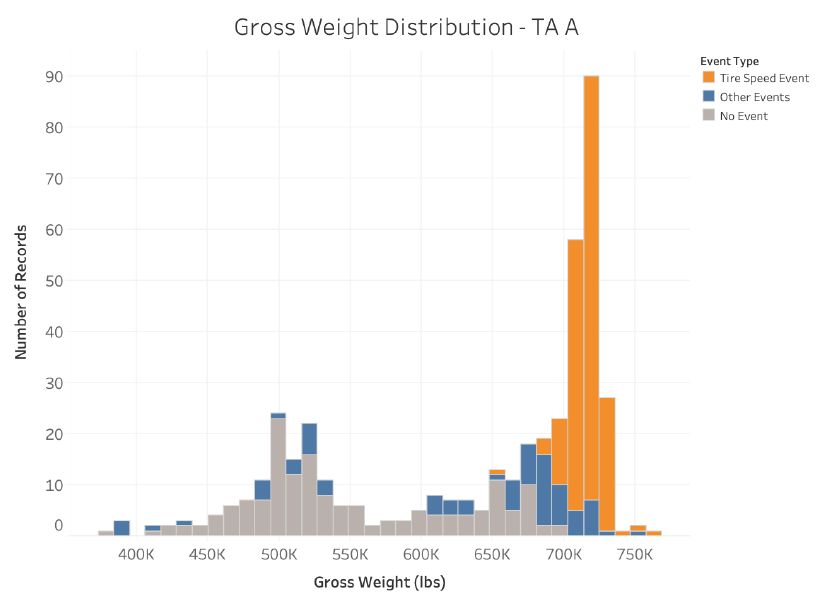
Figure 9. Gross weight distribution for twin-aisle airframe A fleet.